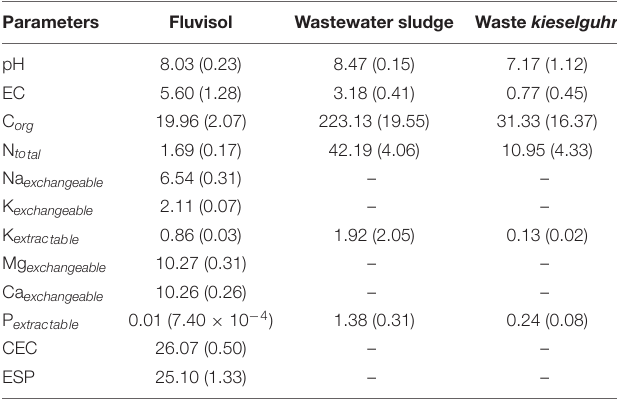
TABLE 1 | Chemical characteristics of the Fluvisol and amendments (mean ± SD, n = 3) collected in Sobralinho, in the Municipal Council of Vila Franca de Xira, west